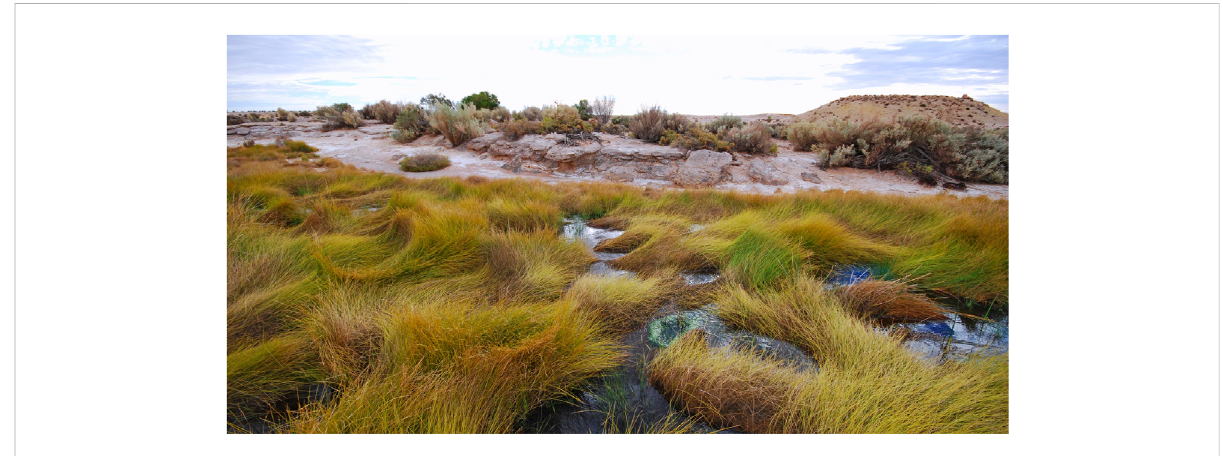
FIGURE 2 View of vegetation in the Jersey spring group (Kati Thanda – Lake Eyre supergroup) dominated by bore-drain sedge ( Cyperus laevigatus ). Photo credit Rachael